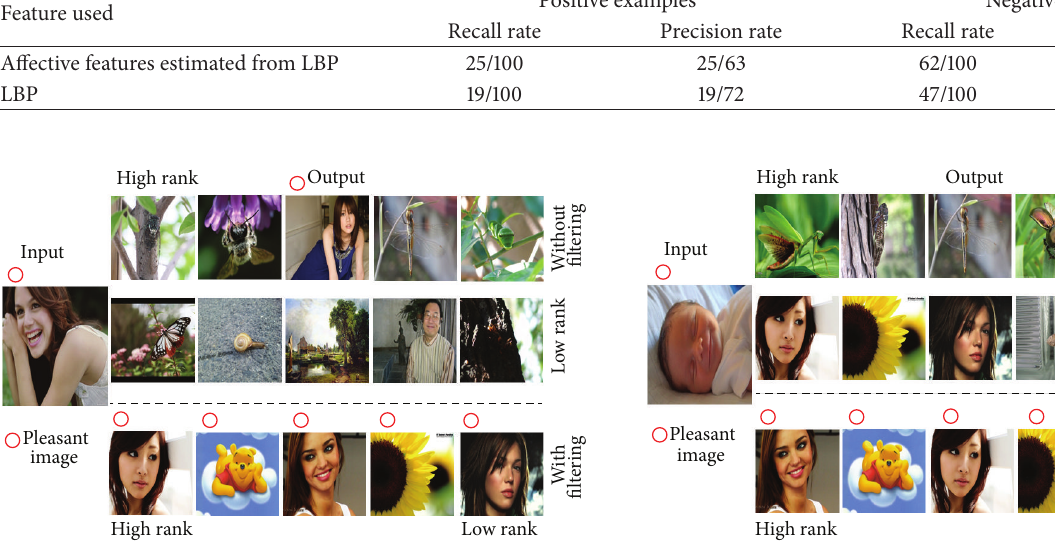
Figure 8: Output results, example